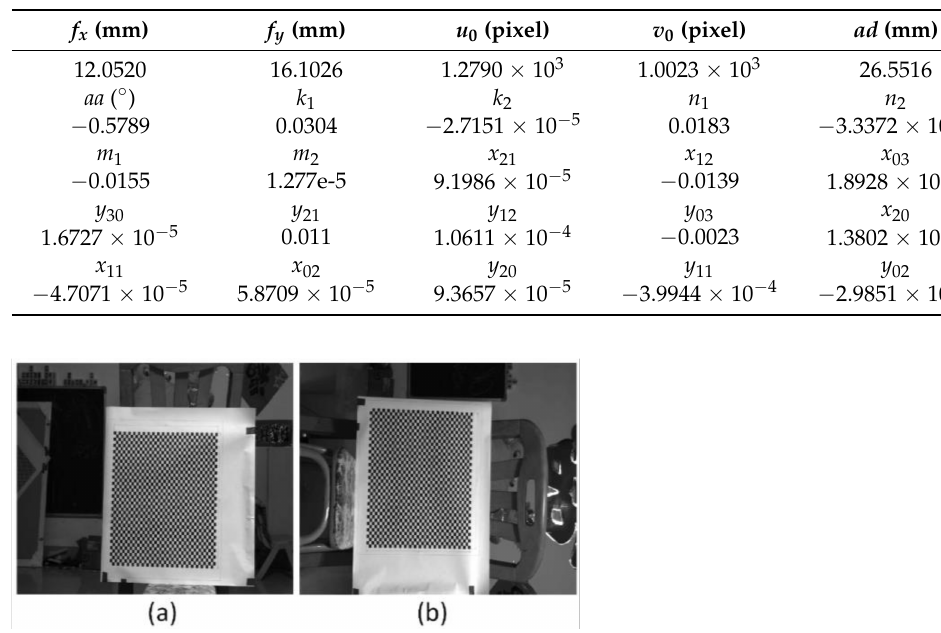
Table 2. Internal parameters of the calibrated anamorphic lens.